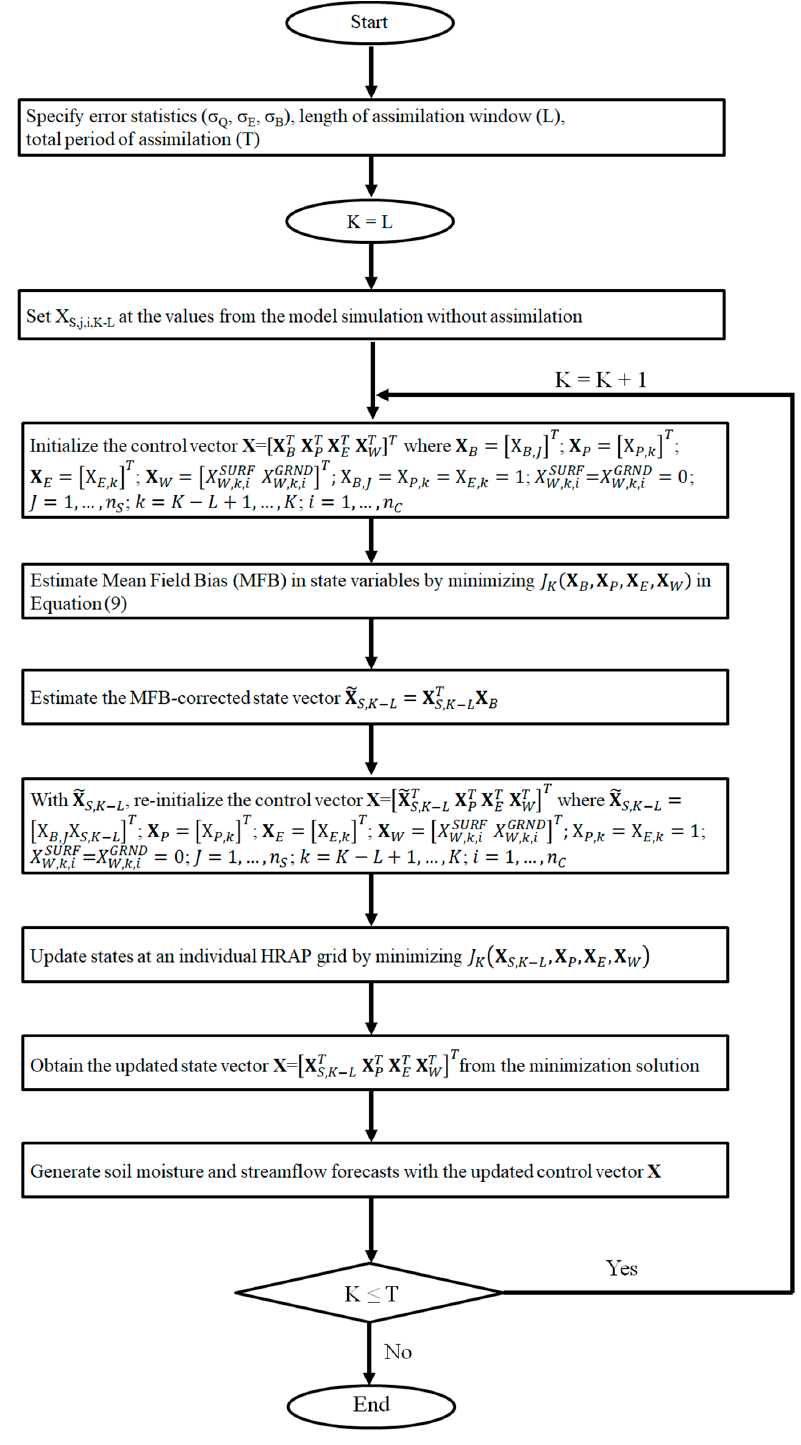
Figure 1. A schematic of the Mean Field Bias (MFB)-aware VAR (MVAR) which corrects MFB in model states via streamflow assimilation.